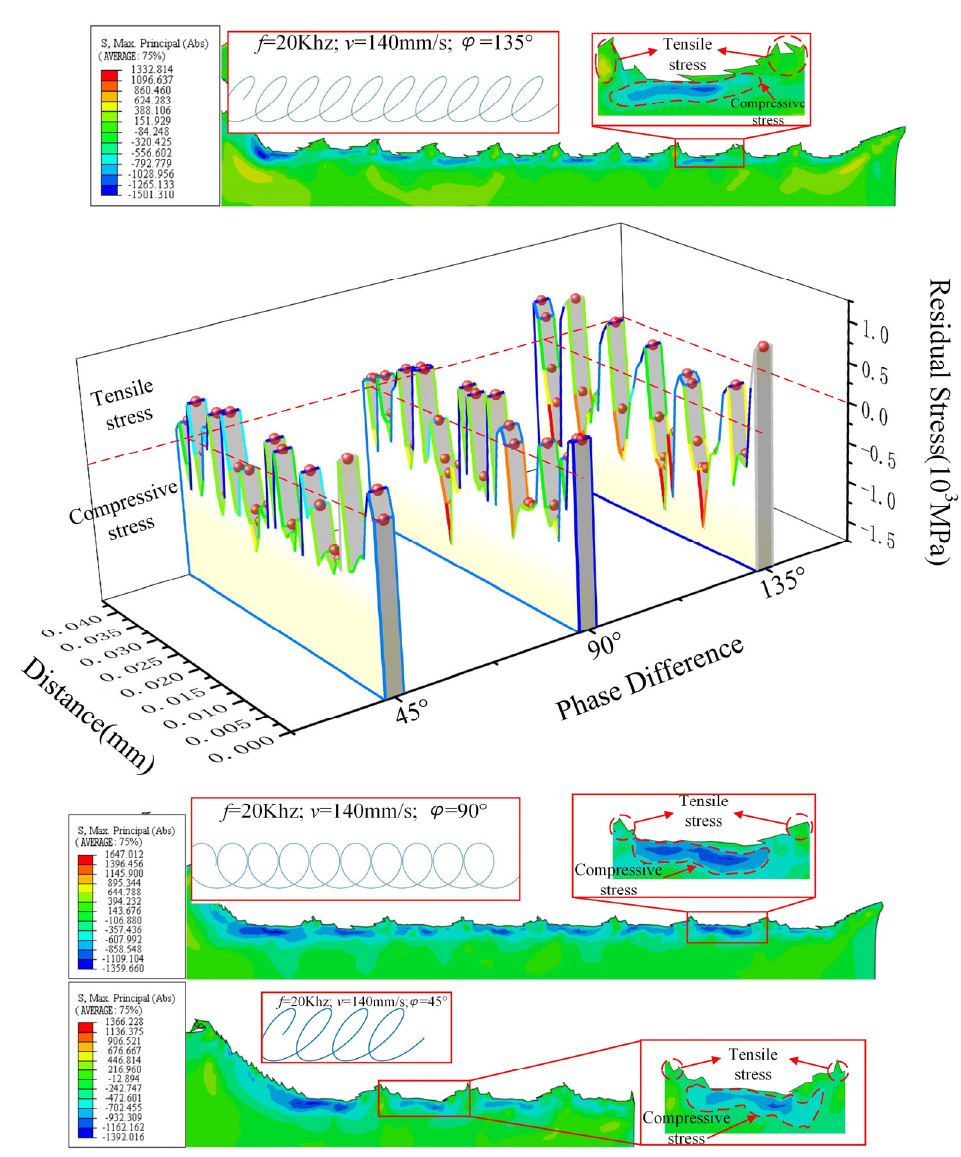
Figure 13. Evolution of surface residual stress of UEVC material.